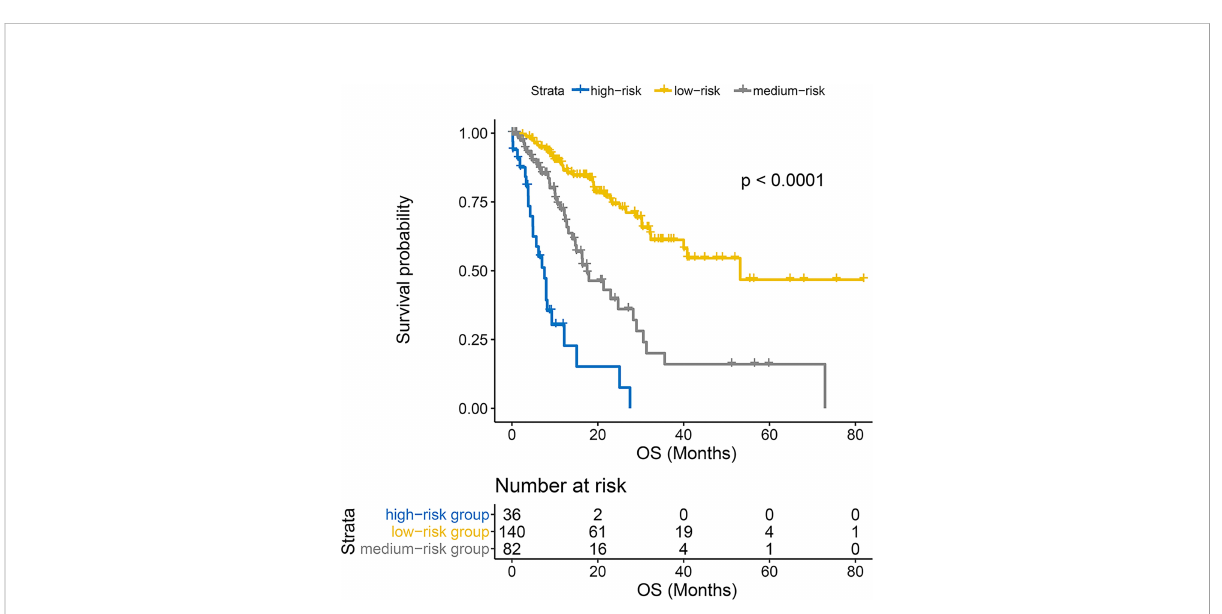
FIGURE 5 Kaplan-Meier curves for overall survival between the high-, medium- and low-risk